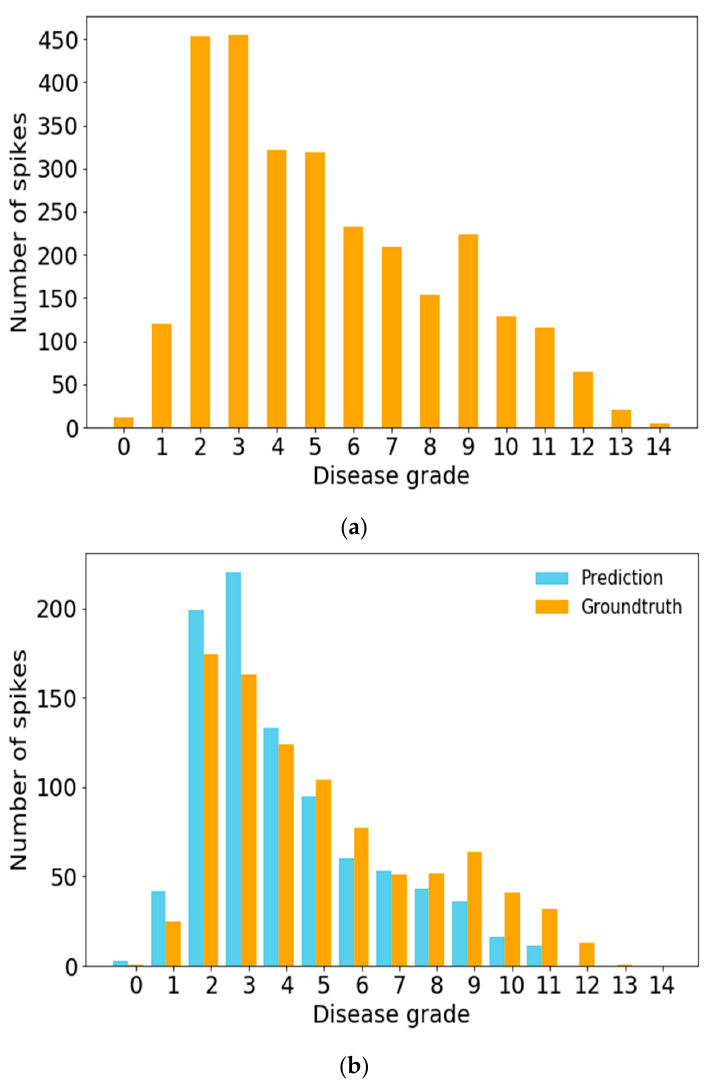
Figure 12. Frequency of wheat spikes of each disease grade; ( a ) the number of wheat spikes at different disease grades in the training set; ( b ) the number of predicted and ground truth spikes in the validation set.